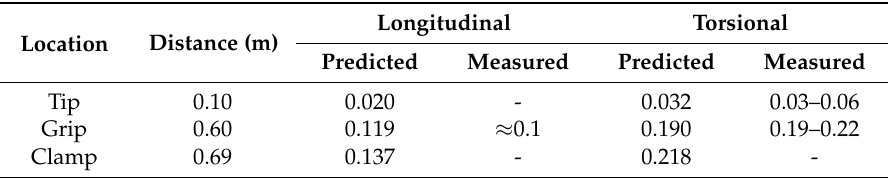
Table 1. Theoretical (predicted) and measured timings (following initial contact) for longitudinal and torsional strain. Values in ms unless otherwise stated.